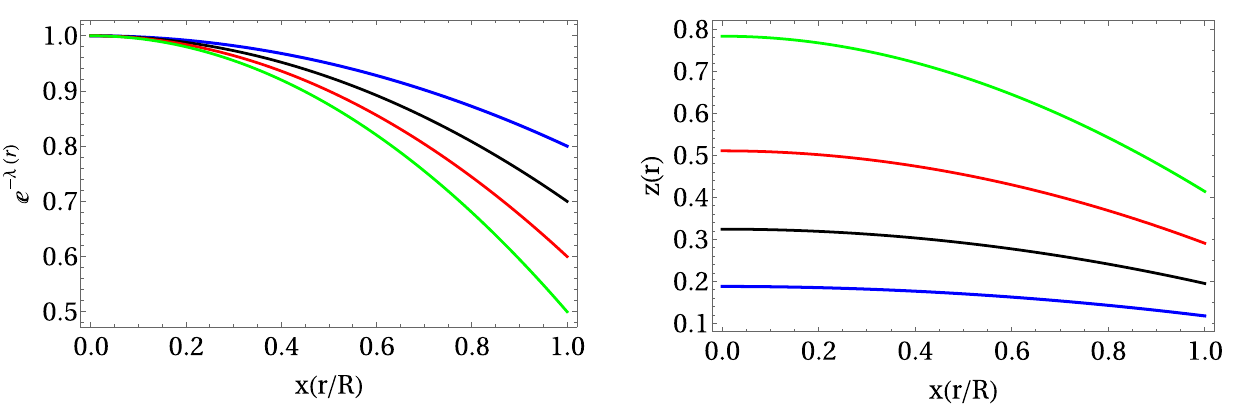
Fig. 5 z ( r ) for Model I: 0.1 (blue line), 0.15 (black line), 0.20 (red line) and 0.25 (green line)